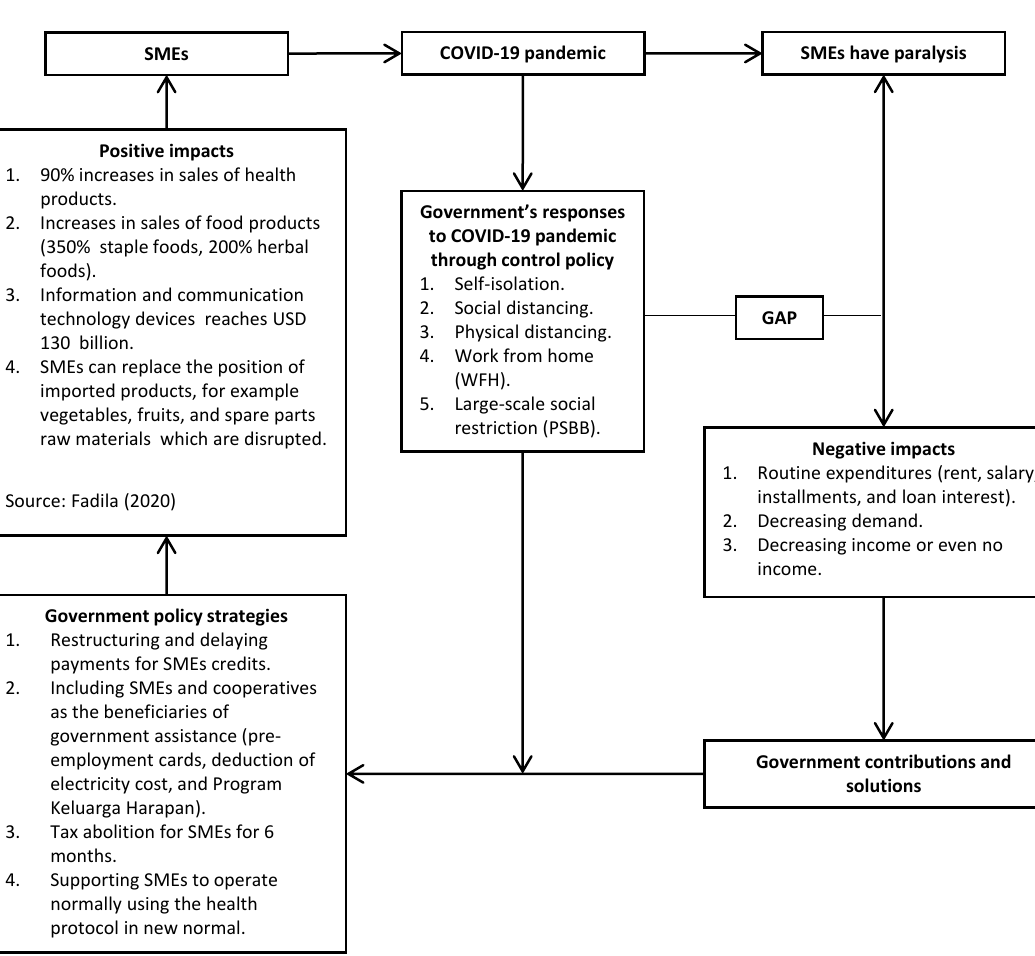
Figure 1. Theoretical